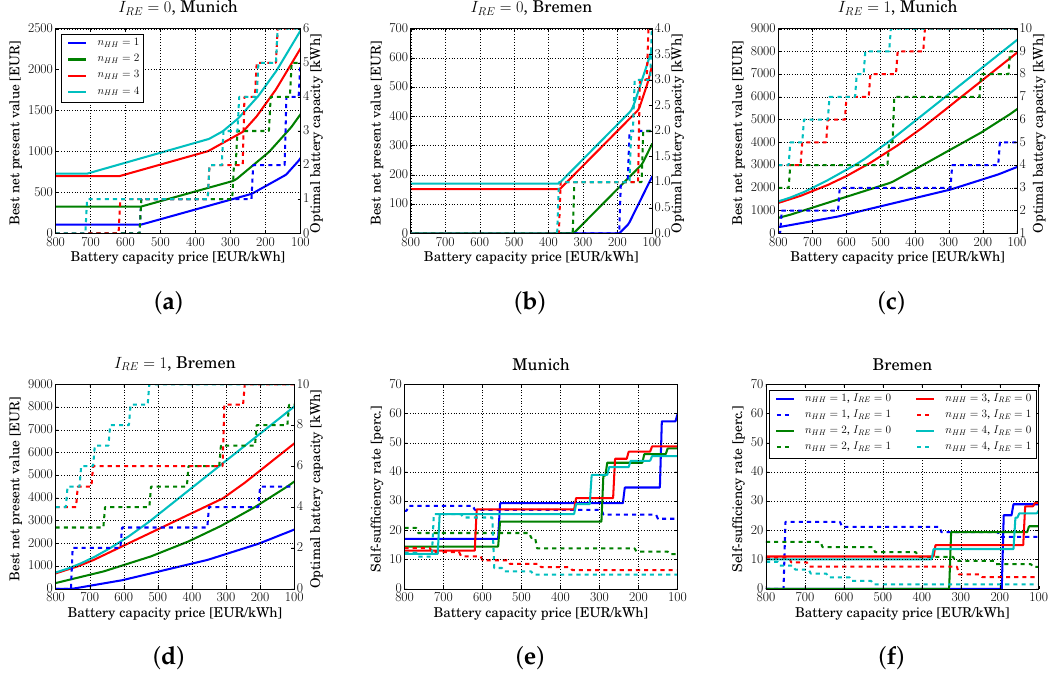
Figure 6. Best NPVs ( a – d ) and corresponding self-sufficiency rates ( e , f ) for different household sizes and